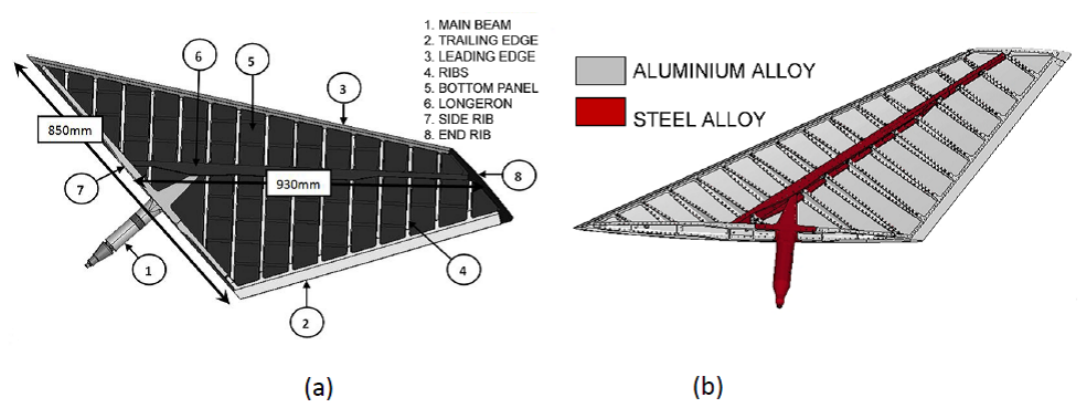
Figure 1: (a) Internal Structural Arrangement, (b) Materials of present structure